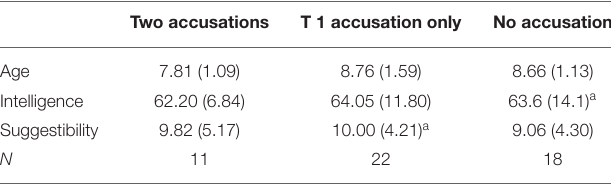
Values displayed are means (standard deviations in parentheses). Two participants made an accusation in the second interview but not the first, due to the small number they